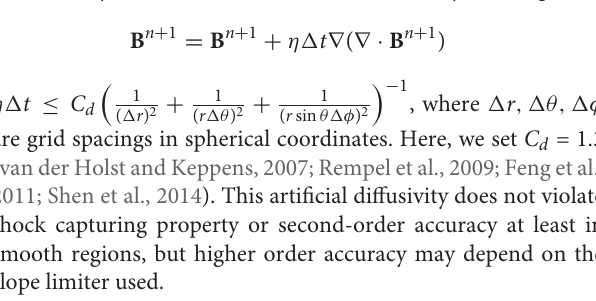
Frontiers in Astronomy and Space Sciences |